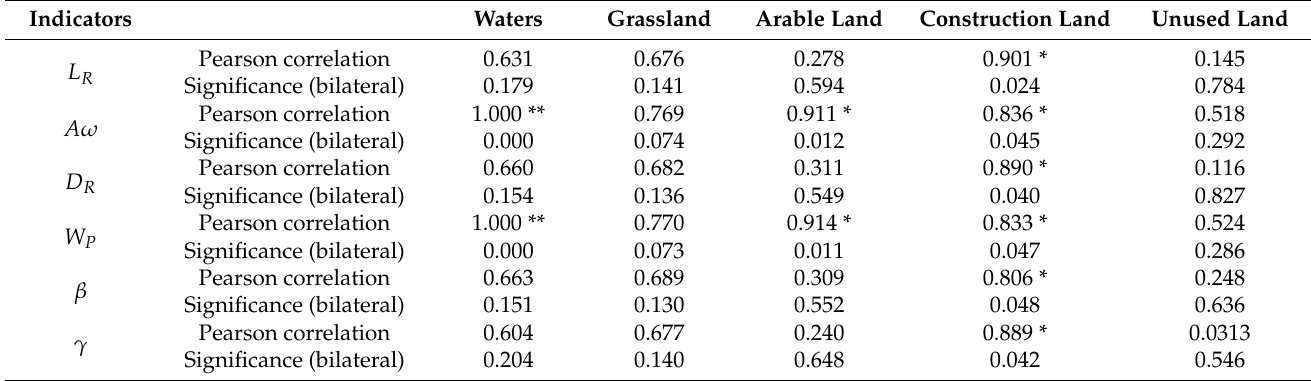
Table 7. Characteristic indexes of water system pattern and Pearson analysis of proportion of each land